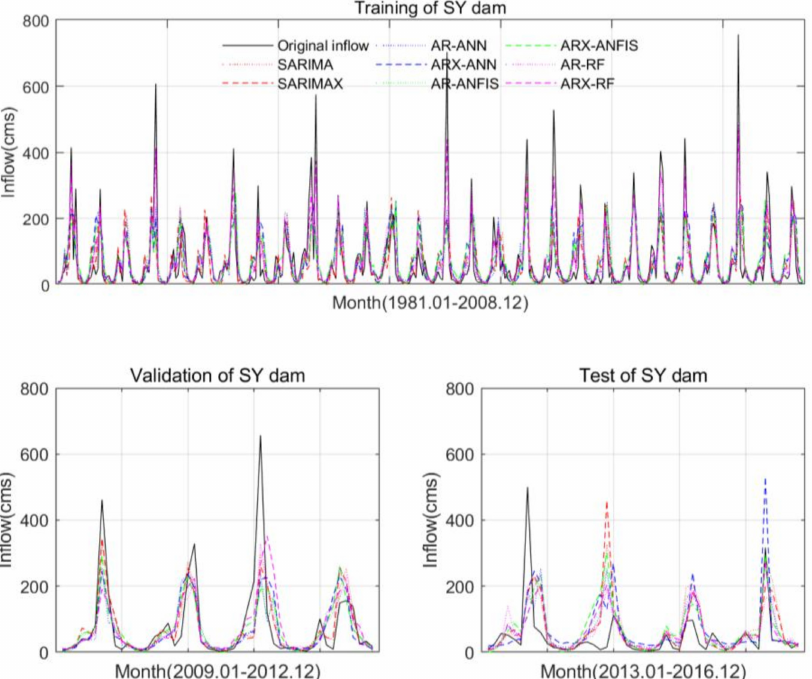
Figure 11. Forecasting results from the eight models in the SY dam during the training, validation, and test periods (a part of the forecasting results in the training period of the SARIMA and SARIMAX models were illustrated for the validation